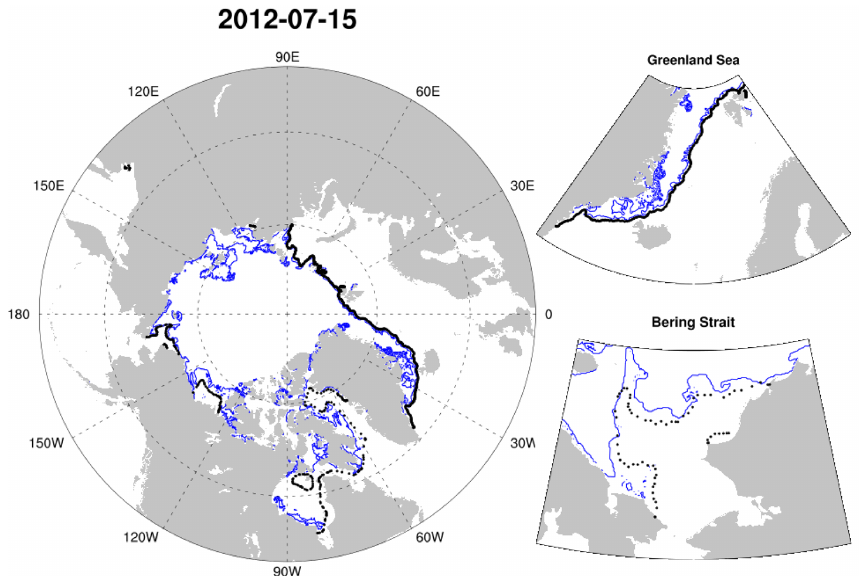
Figure 6. Ice edge location for 15 July 2012 from the NIC (black dots) and the IMS/MASIE (blue line) products for the full Arctic (left panel) and zoomed areas of the Greenland Sea (upper right panel) and the Bering Strait (lower right panel). The black dots represent the presence of any known ice and is used to determine a conservative edge location. The blue line represents a gridded field (4km with > 40% concentration) that may provide more spatial detail at smaller scales.